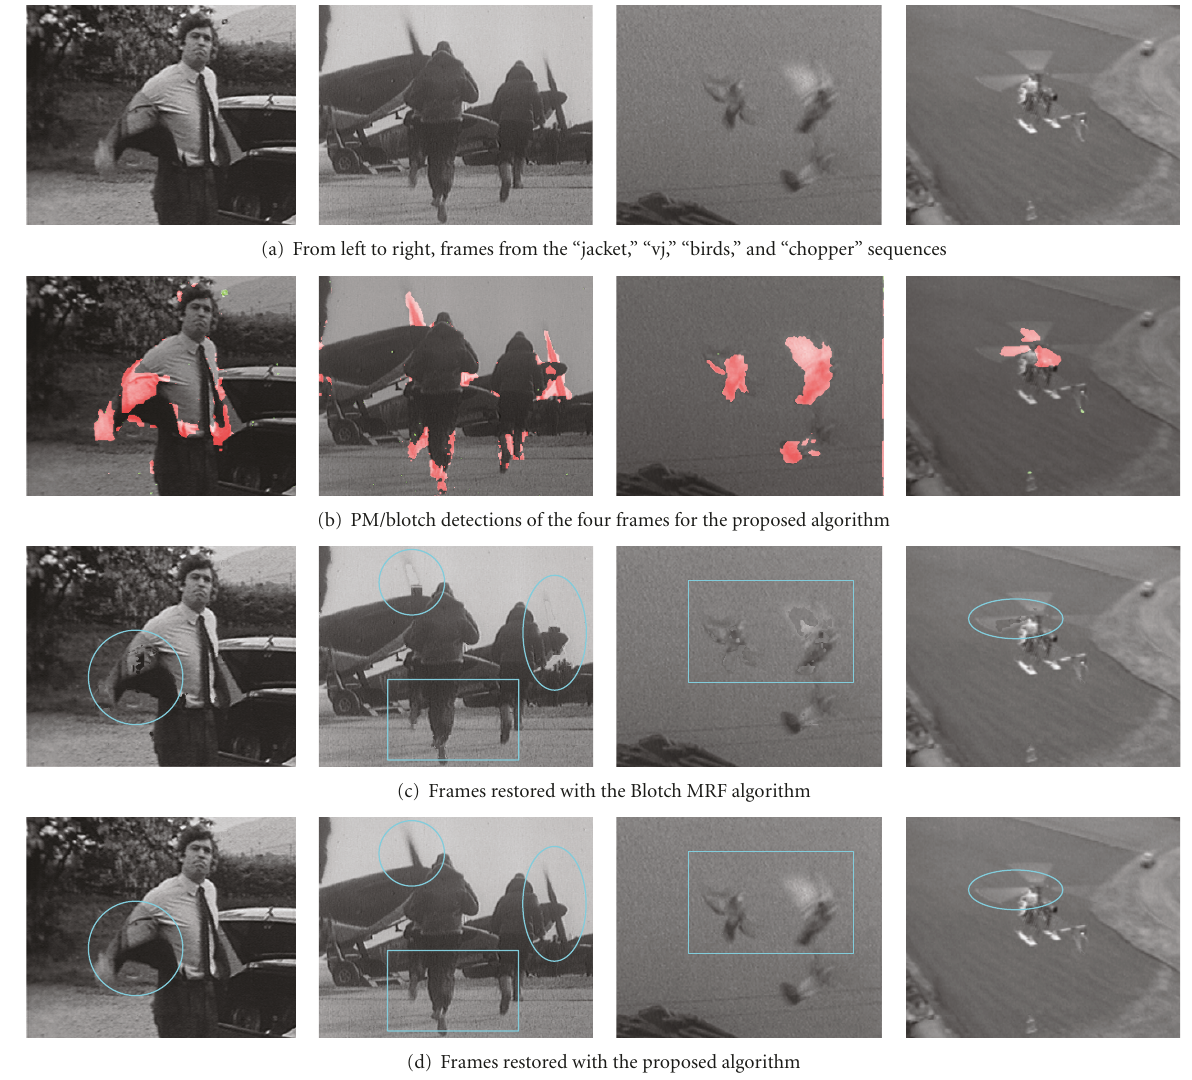
Figure 17: This figure shows frames from four sequences restored using the Blotch MRF and proposed algorithms as blotch detectors. The highlighted frames show image damage present if the Blotch MRF is used instead of the proposed